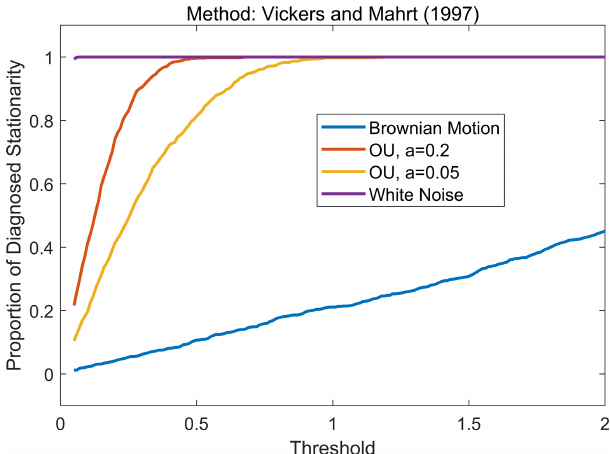
Figure 7. The impact of IN on the non-stationarity diagnosis method proposed by Vickers and Mahrt (1997). The proportion of diagnosed stationarity is plotted as a function of threshold. The functions for the white noise, the OU process with a = 0 . 2 and b = 0 . 7, the OU process with a = 0 . 05 and b = 0 . 7, and the Brow- nian motion are shown by different colour lines, as listed in the leg- end. The number of generated time series of each model is 1000. To avoid the zero denominator in Eq. (11), the averages of all generated time series are set to